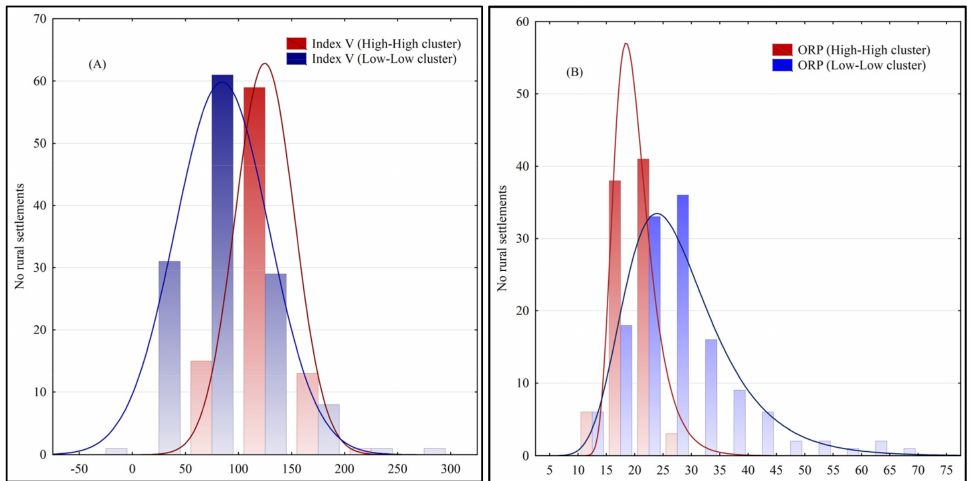
Figure 7. Histogram of demographic variables in rural settlements: ( A ) vitality index (Index V ) and ( B ) old rural population ( ORP ) according to the high–high cluster and the low–low